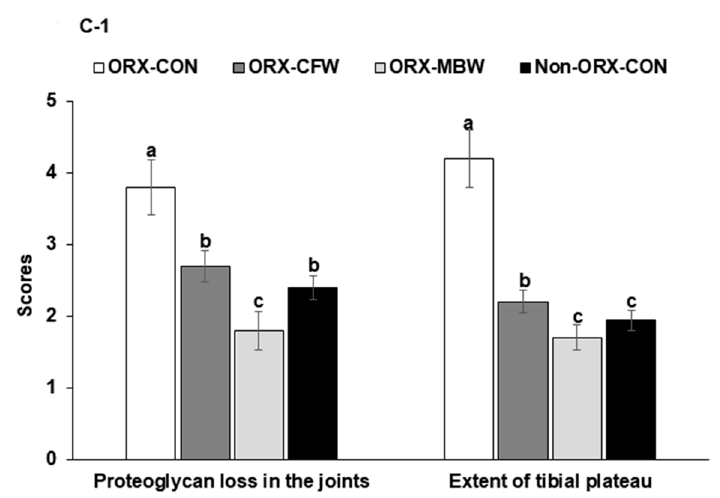
Figure 3. The mRNA expression of matrix metalloproteinases (MMP) and proinflammatory cytokines in the articular cartilage and the histopathological features of osteoarthritic lesions at 21 days after an intra-articular injection of monoiodoacetate (MIA). ORX-CON, orchidectomized (ORX) male rats were fed with a 43% fat diet with 0.5% dextrin; ORX-CFW, ORX male rats were fed with a 43% fat diet with 0.5% CFW; ORX-MBW: ORX male rats were fed with a 43% fat diet with 0.5% MBW; Non-ORX-CON, Sham male rats were fed with a 43% fat diet with 0.5% dextrin. CFW, water extract of Cornus o ffi cinalis Siebold and Zucc fruits; MWB, water extract of Morus alba L. root bark ( A ) mRNA expression of matrix metalloproteinase (MMP)-3, MMP-13, tumor necrosis factor (TNF)- α , and interleukin (IL)-1 β in the articular cartilage. ( B ) The damage to articular cartilage damage and subchondral bone in hematoxylin-eosin (H-E) stain (magnifying power × 100 and × 200 in the image). Red and violet arrows indicated the damage to the articular cartilage and gap between the joints. ( B-1 ) Scores of the damage to articular cartilage damage and subchondral bone from H-E staining. ( C ) The proteoglycan loss in the joint and extent of the tibial plateau in Safranin O fast green (SG) stain (magnifying power × 100). Red color represents the proteoglycan contents in the articular cartilage, and the violet arrow indicated the gap between joints. ( C-1 ) Scores of the proteoglycan loss in the joint and extent of the tibial plateau from the SG stain. Each data point and error bar represent the mean ± SD from five rats per group. a,b,c Di ff erent letters indicate significant di ff erences in the treatment groups by Tukey’s test at p < 0.05. The ‘a’ letter on the group had a significant di ff erence of mean value to the ‘b’ letter on the group at p < 0.05.